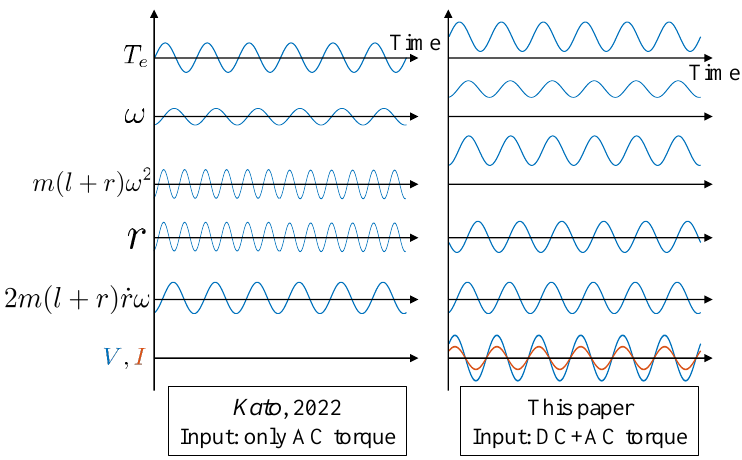
Figure 2. Principle of the electrical power generation in the proposed harvester compared with that reported in